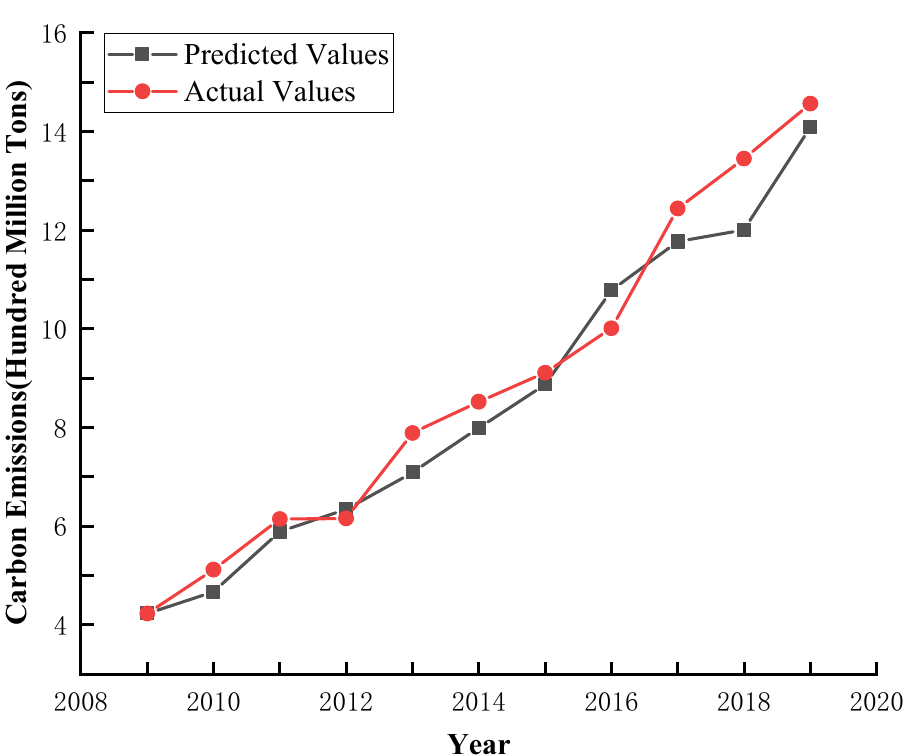
Figure 5. Comparison between the actual and predicted carbon dioxide emissions in the Yellow River Basin.